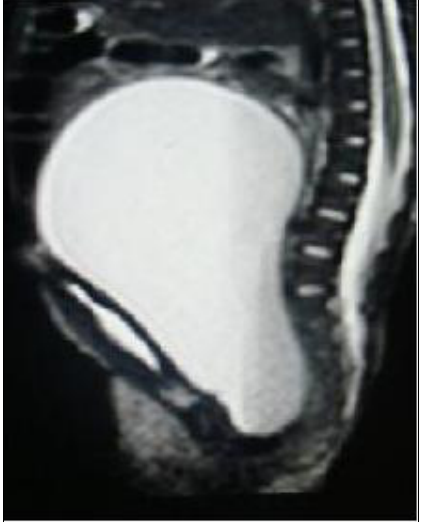
Figure 4: MRI of hydrometrocolpos with vaginal